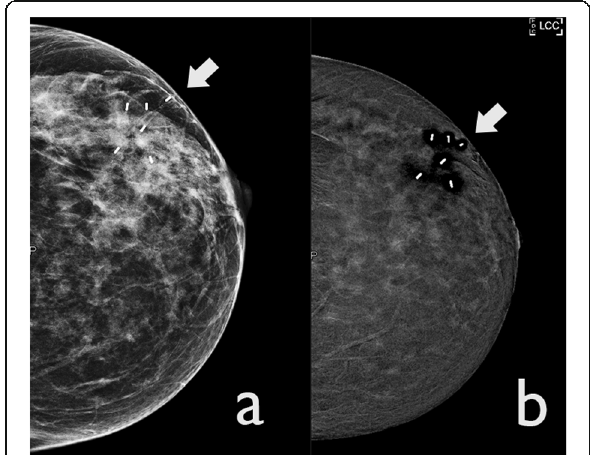
Fig. 7 Artefact due to the presence of post ultrasound guided biopsy markers: a LE CEDM image. There are some markers seen at the outer quadrant of the left breast (arrow); b in the recombined image, the markers are seen as high attenuation structures and they demonstrate a surrounding dark halo